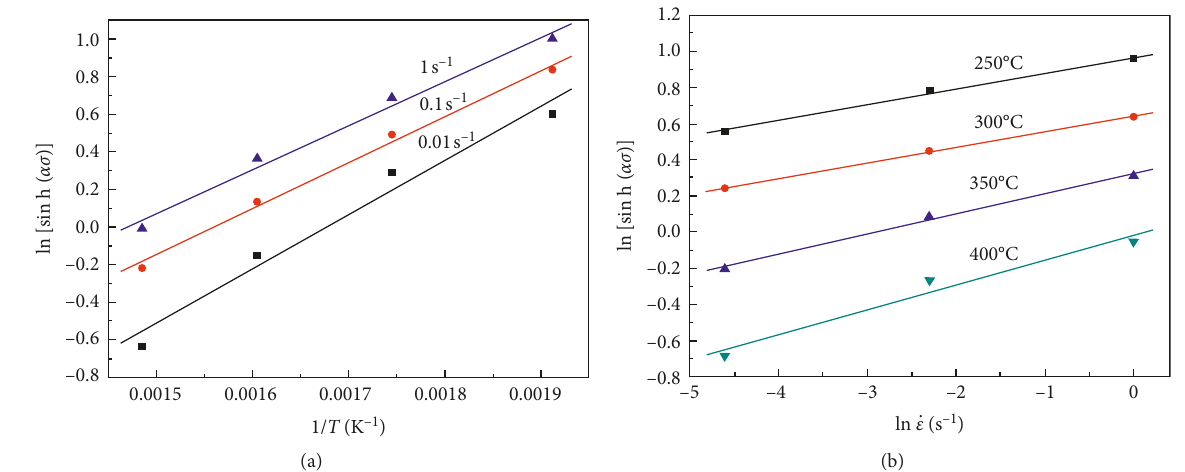
Figure 3: Curves of peak stress versus strain-rate and temperature under different conditions: (a) ln [ sinh ( ασ )] − ( 1 /T ) ; (b)ln _ ε − ln [ sin h ( ασ )] .